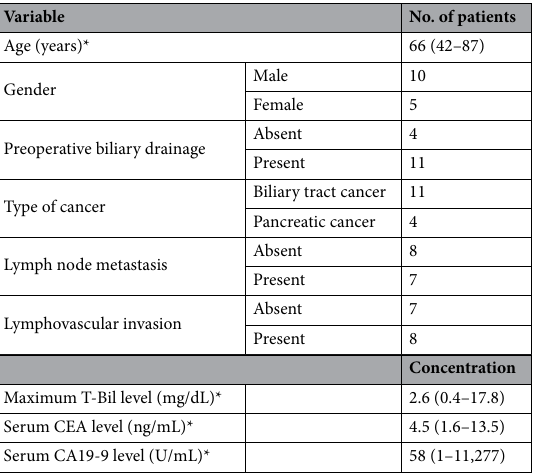
Table 1. Clinicopathologic characteristics of 15 patients with biliary tract or pancreatic cancer. T-Bil, total bilirubin; CEA, carcinoembryonic antigen; CA19-9, carbohydrate antigen. *Data are expressed as median